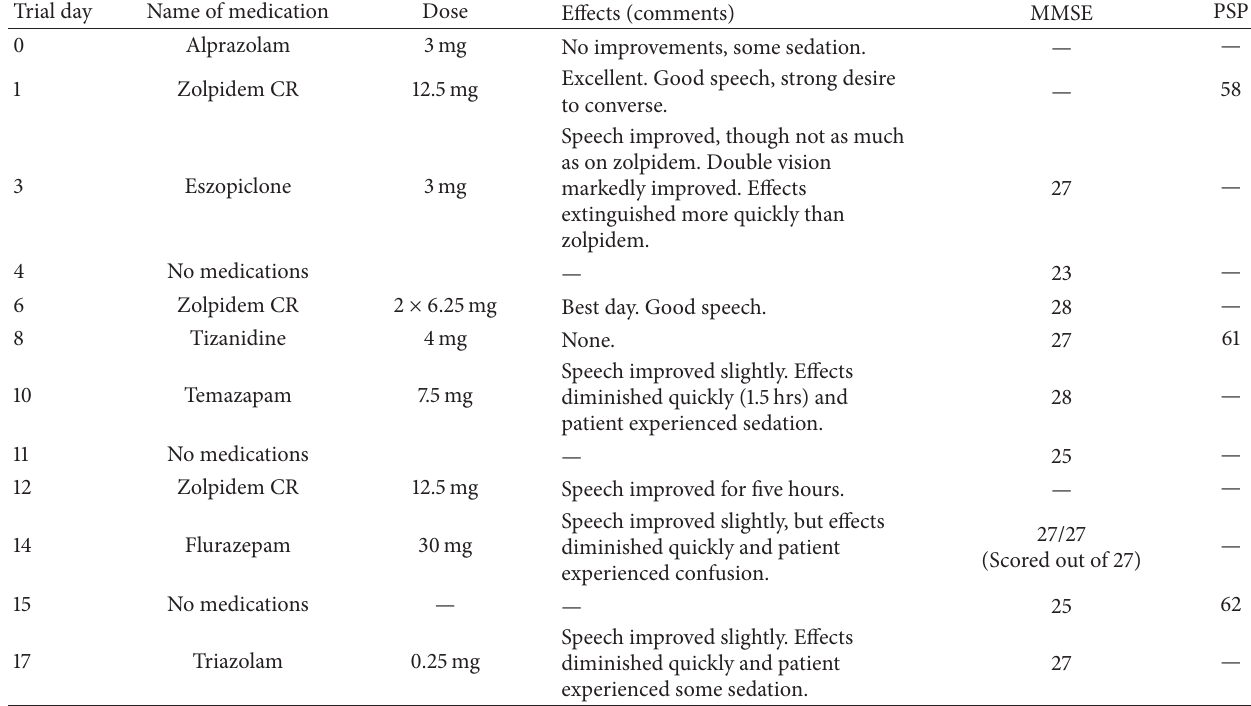
Table describing the patient’s response to the various medications. MMSE: Folstein’s minimental status exam, scored out of 28 points; higher score denotes higher cognitive function. PSP: progressive supranuclear palsy rating scale (Foundation for PSP, CBD and Related Brain Disease), scored out of 100 points; lower score denotes better symptoms and higher functional